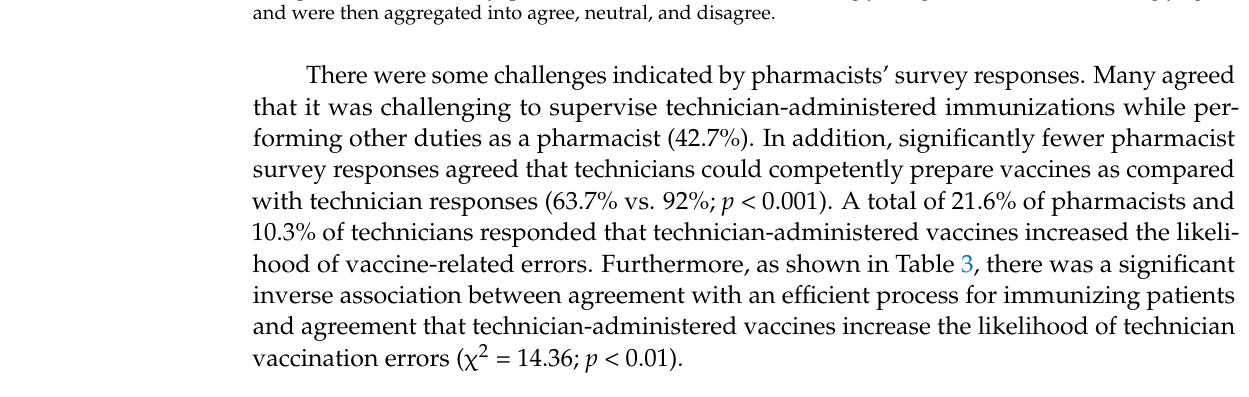
Table 3. Cross-tabulation showing observed cell counts between pharmacist and pharmacy technician perception of an efficient process or sufficient space for immunization services and the likelihood of vaccination errors associated with technician vaccine